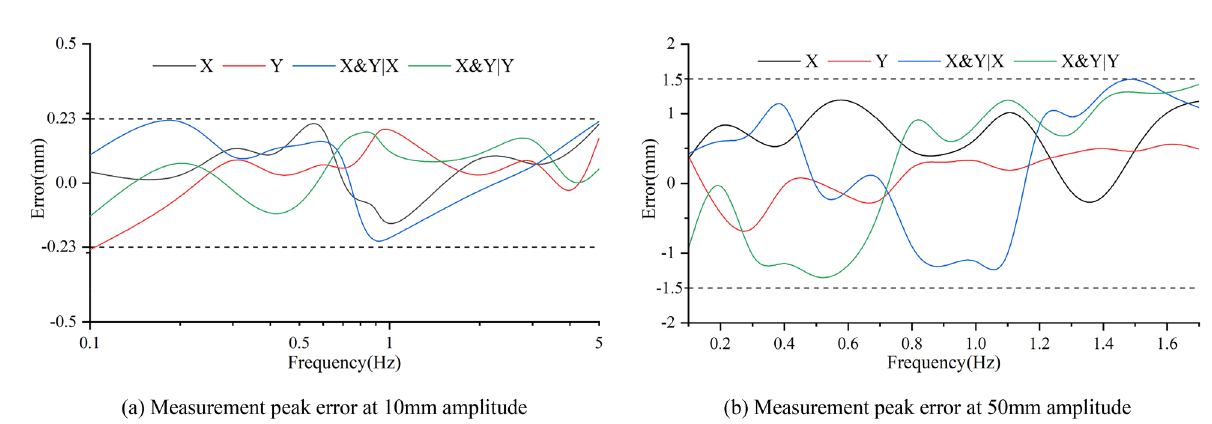
Figure 24. Peak measurement error of the sensor at various frequencies (( a , b ) were generated by Origin 2016 × 64 (https:// www. origi nlab. com/